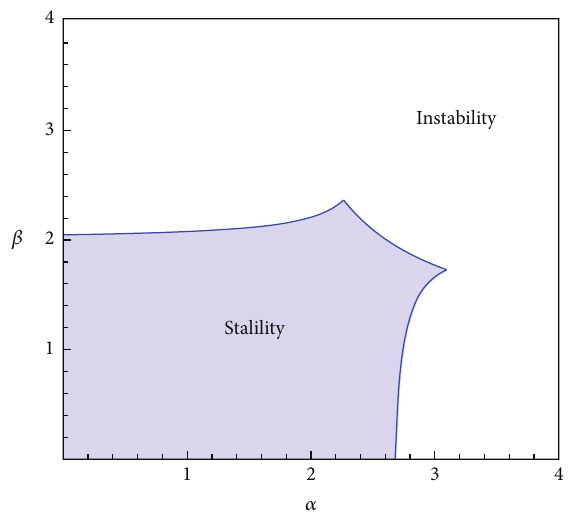
Figure 1: The stability and instability region of the Nash equilibrium point 𝐸 ∗ of system